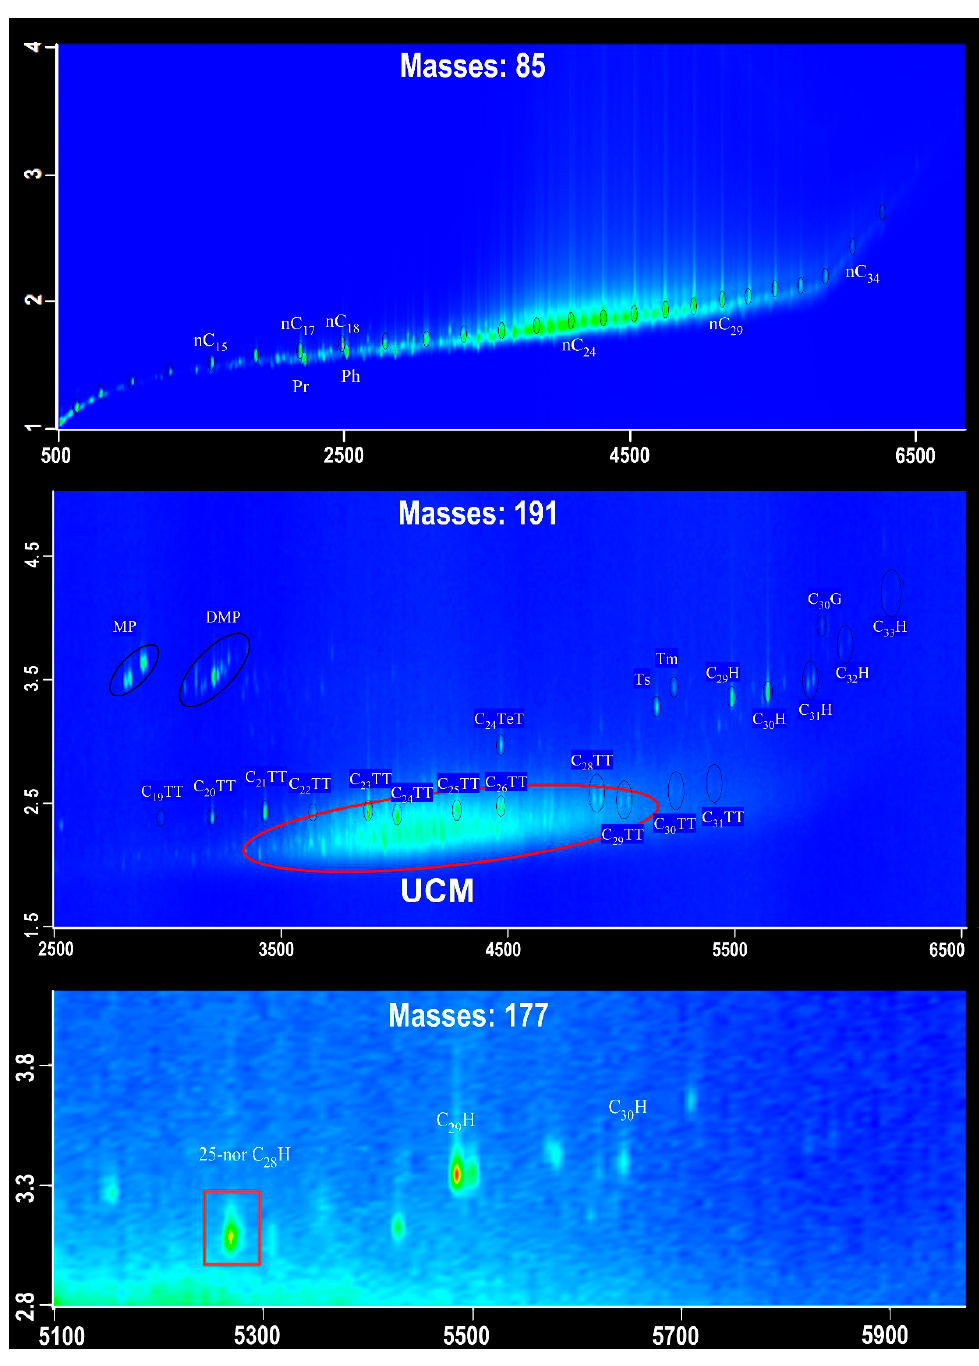
Figure 4. Representative two-dimensional chromatograms of fragment ions m / z 85, 177, and 191. UCM, unresolved complex mixtures; MP, methylphenanthrene; DP, dimethylphenanthrene; TT, tricyclic terpane; H, hopane; C 30 G, gammacerane. The numbers above the main peak indicate the carbon atom numbers of n -alkanes ( m / z 85), tricyclic terpanes, and hopanes ( m / z 191 and 177). Pr and Ph indicate pristane and phytane, respectively.